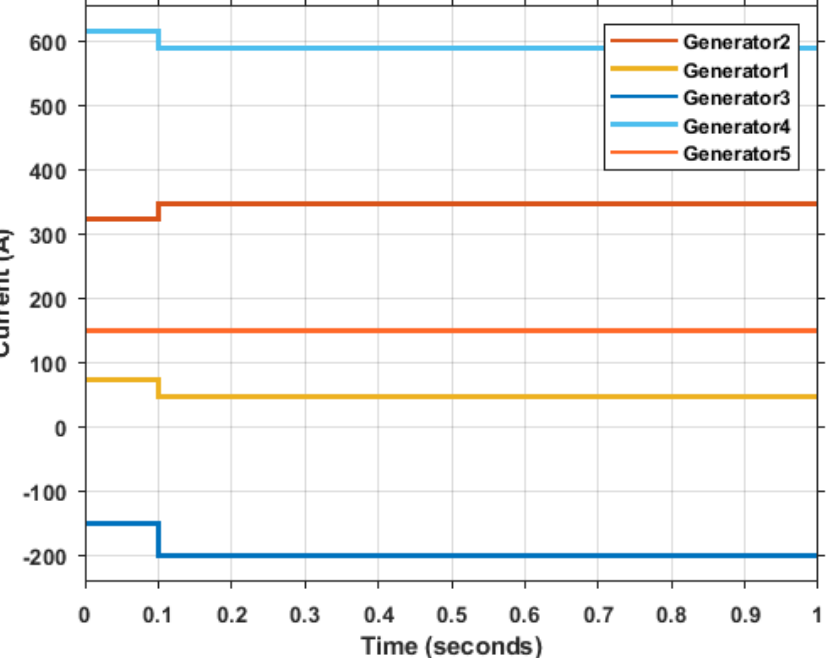
242.3 Table 5. Comparison between the performance of the DCSOP and the normal conductor in terms of the change of generator currents. Generators